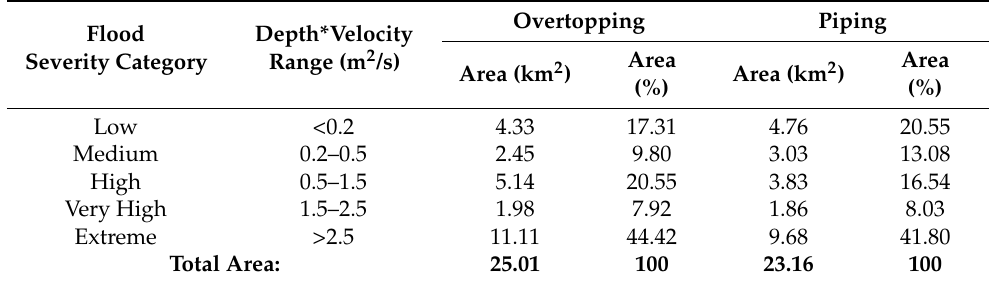
Table 10. Flood severity classes for the product of water depth and velocity and the inundated area per class (first classification approach).